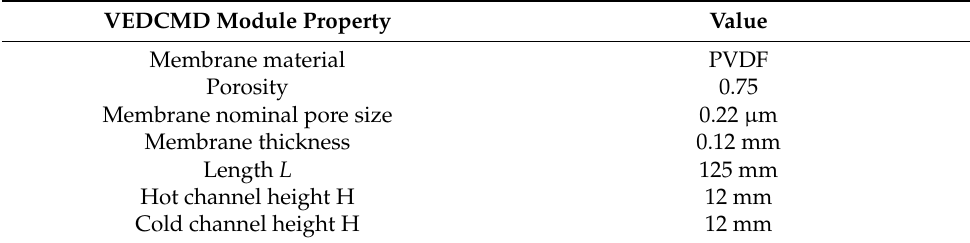
Figure 1. Simplified 2D geometrical model of the flat-plate VEDCMD module. Table 1. Characteristic parameters of the flat-plate module of VEDCMD.